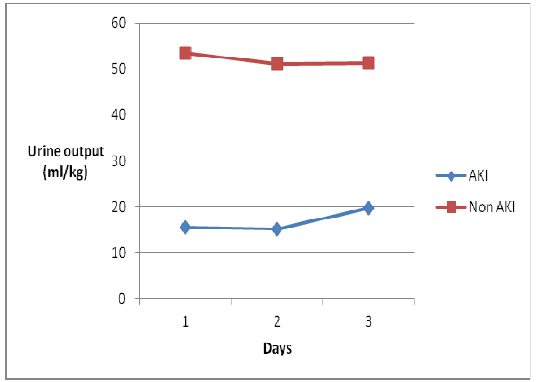
Figure 1 : Urine output in postoperative period in AKI and non AKI group.